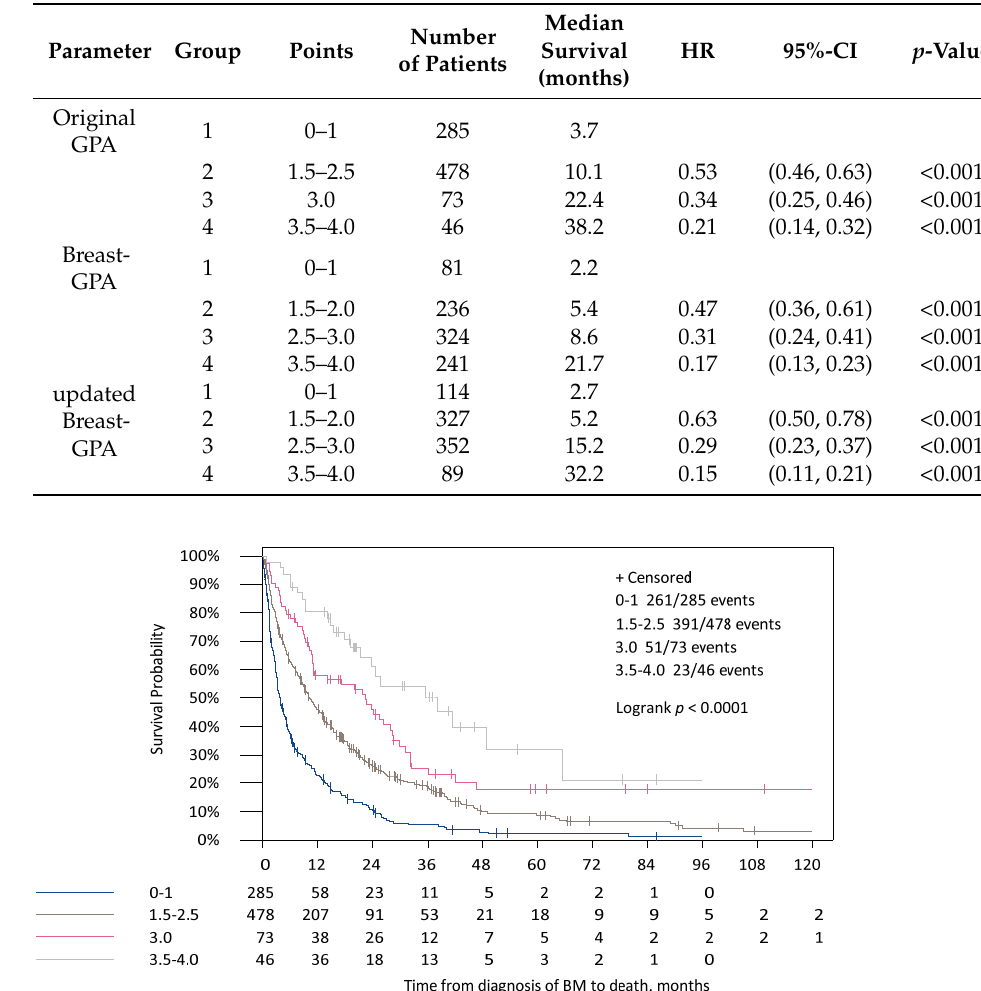
Figure 1. Survival times for the time from diagnosis of BM to death in the four categories of the original GPA Score. The median survival times between the four categories of the Breast-GPA score were shown to be at 2.2, 5.4, 8.6 and 21.7 months (Table 4, Figure 2). Only 9.2% of patients were included in the worst prognostic group ( n = 81), whereas 27.3% of patients were included in the best prognostic group ( n = 241). Logrank p < 0.0001